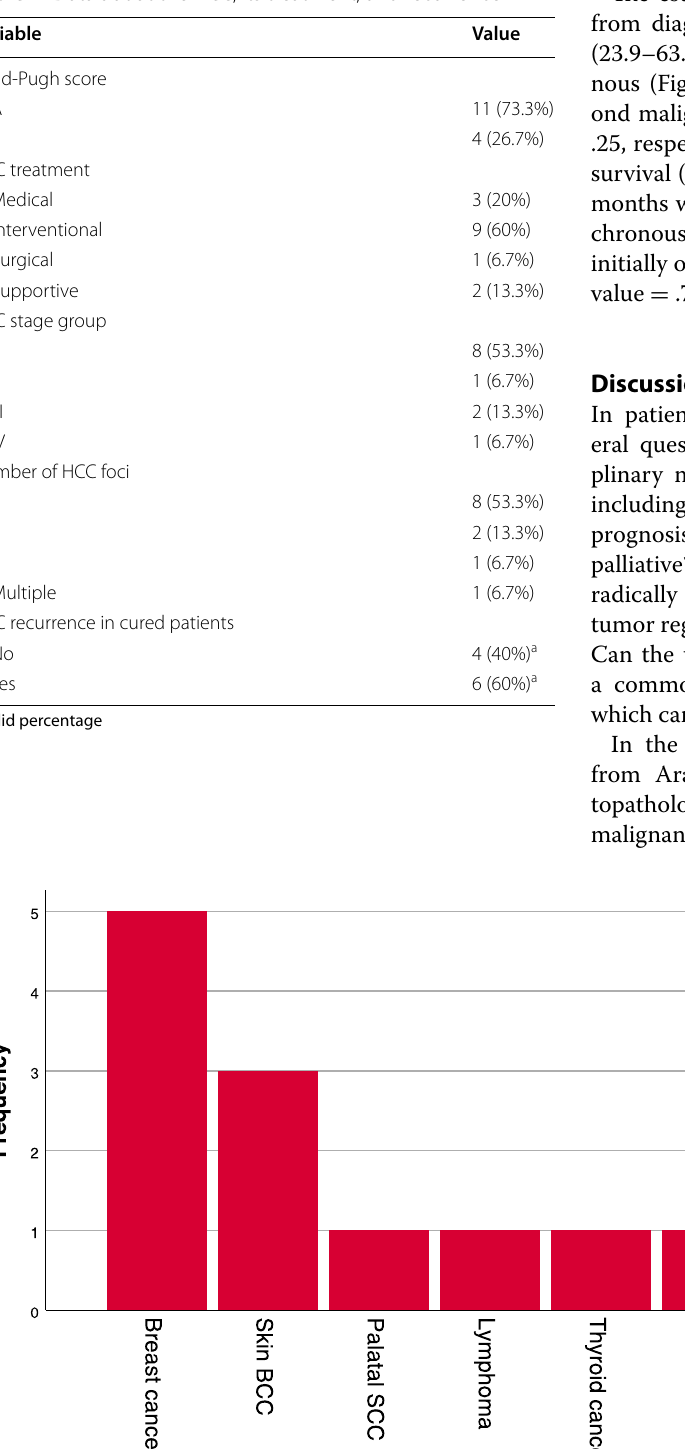
Table 2 Data about the HCC, its treatment, and recurrence